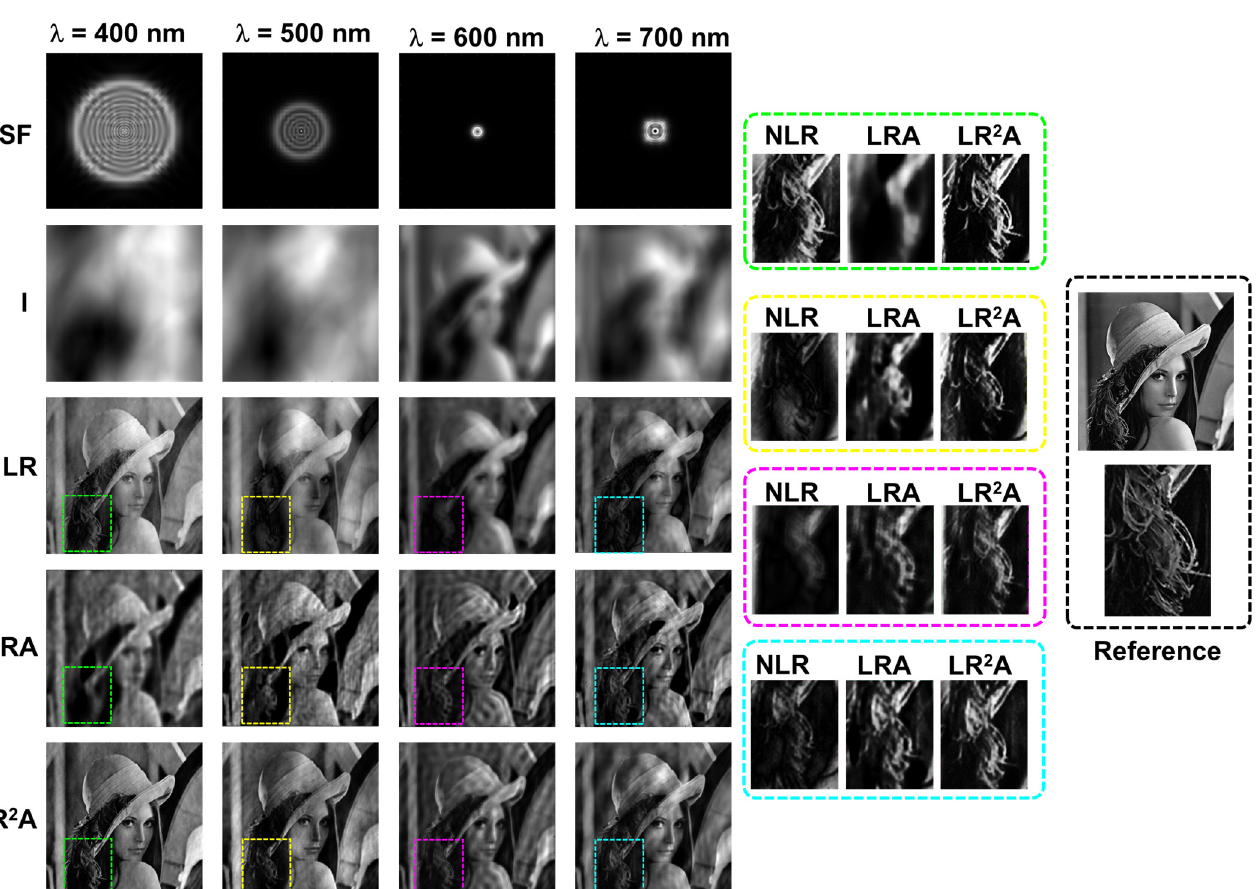
Figure 4. Deblurring results of NLR, LRA, and LR 2 A for di ff erent axial aberrations values Δ z = 0, 25, 50, 75, and 100 mm.